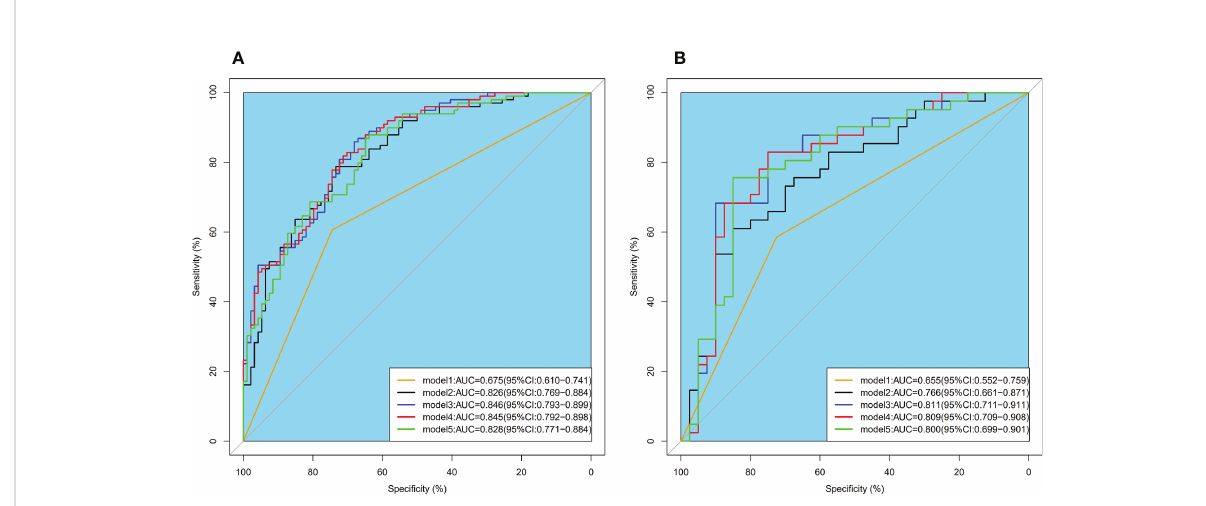
FIGURE 6 ROC curves of model 1-5 intraining (A) and validation (B) dataset. ROC, receiver operator characteristic; AUC, area under the curve.